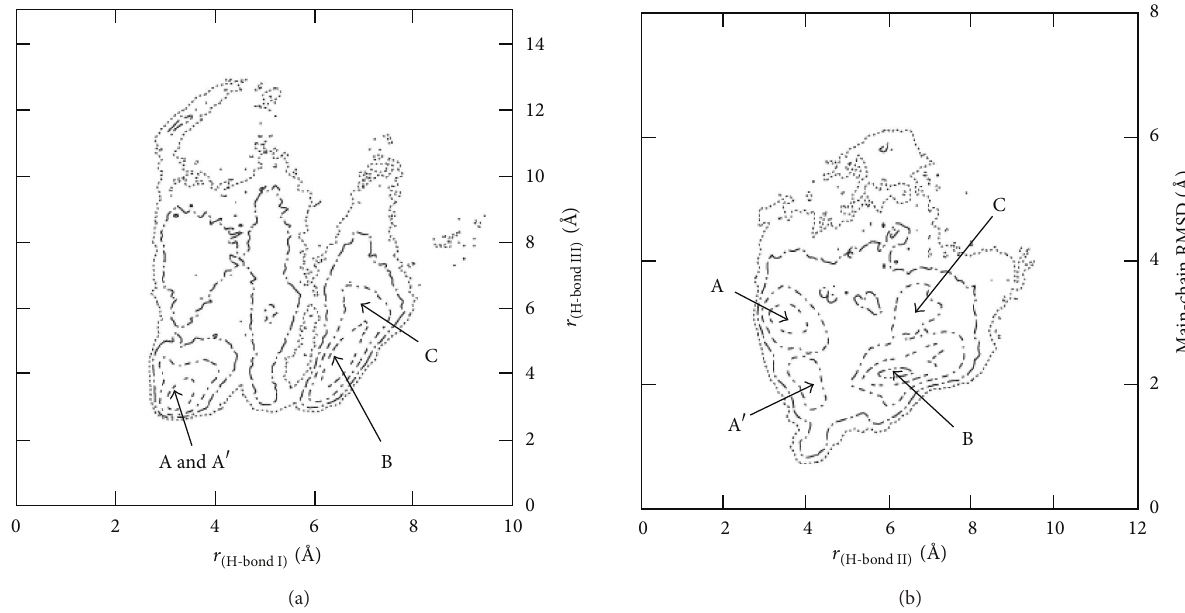
Figure 9: Free-energy surfaces of chignolin projected on the hydrogen bonds I versus III plane (a) and on the hydrogen bond II versus main- chain RMSD plane (b) obtained from all trajectories of the SAAP-MC simulation at 300K in water. Contour lines are drawn in an interval of